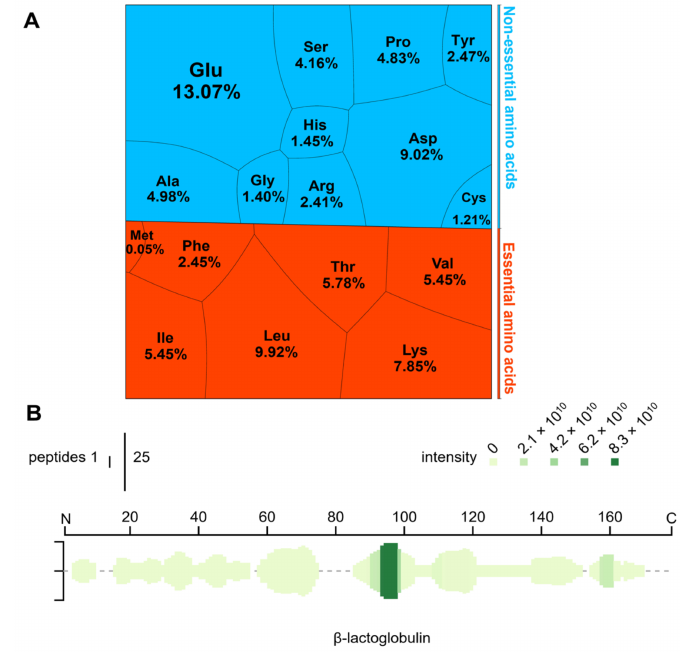
Figure 1. Basic information on the proteinaceous components of whey protein hydrolysate